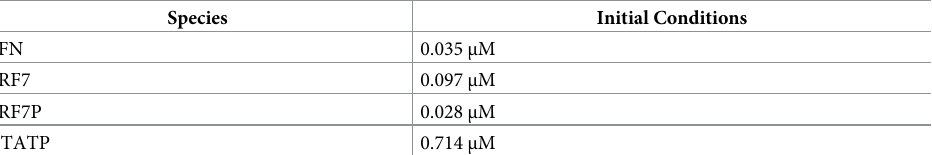
Table 3. Intracellular chemical concentrations in cells 12 hours after in silico exposure to IFN e . These values pro- vide the initial conditions for IFN prestimulation